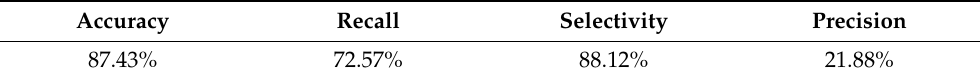
Table 7. Network parameters computed for the experimental data (sample